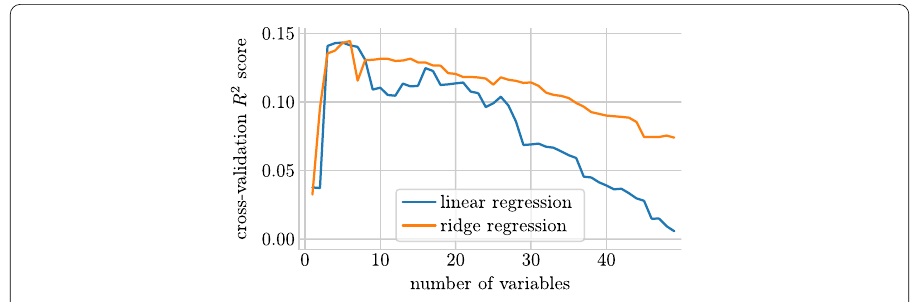
Figure 5 Performance of models (linear regression and ridge regression) on the training set while slowly removing variables